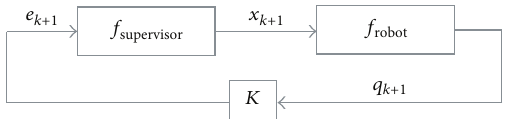
Figure 1: A graphical representation of the global